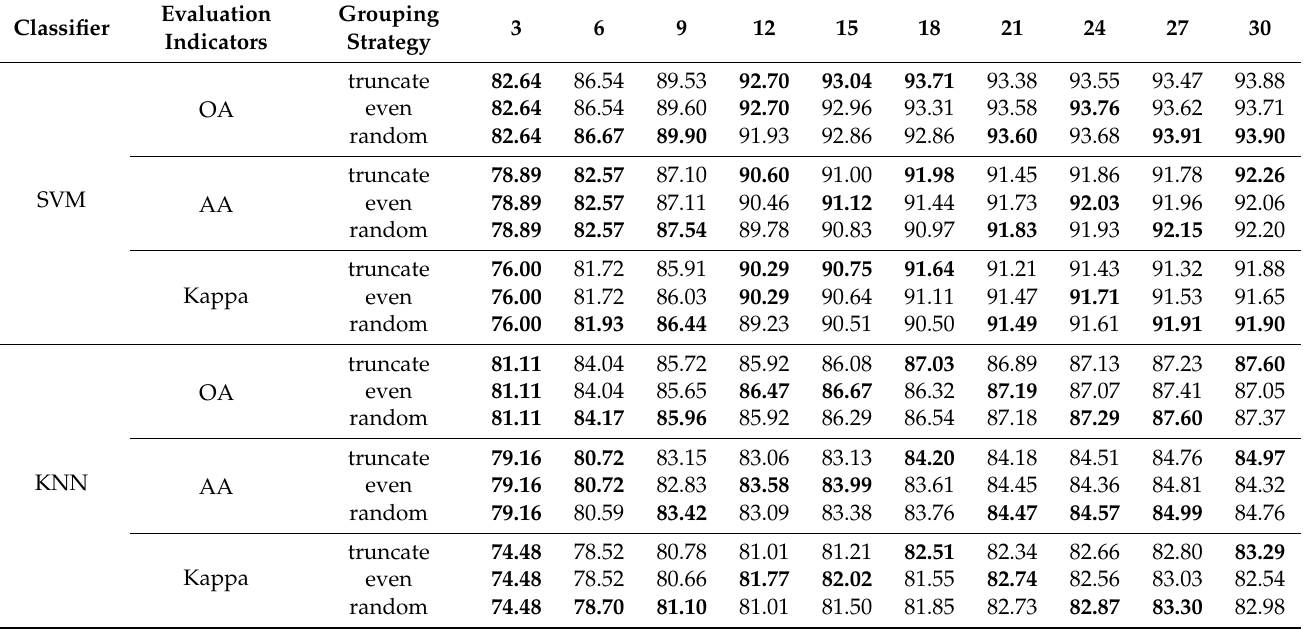
Table 4. Classification results of using different grouping strategies on the Pavia University